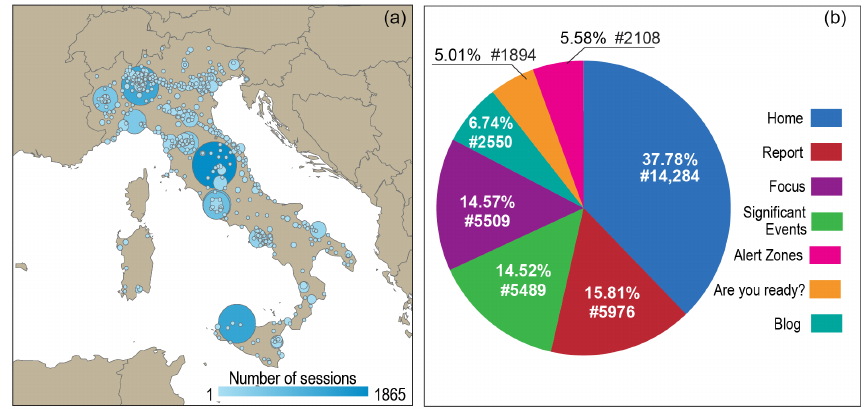
Figure 3. General statistics from Google Analytics for the 638-day period from 16 January 2014 to 15 October 2015. (a) Map showing the geographical distribution of the sessions in Italy. (b) Pie chart shows number of page views for different sections of the